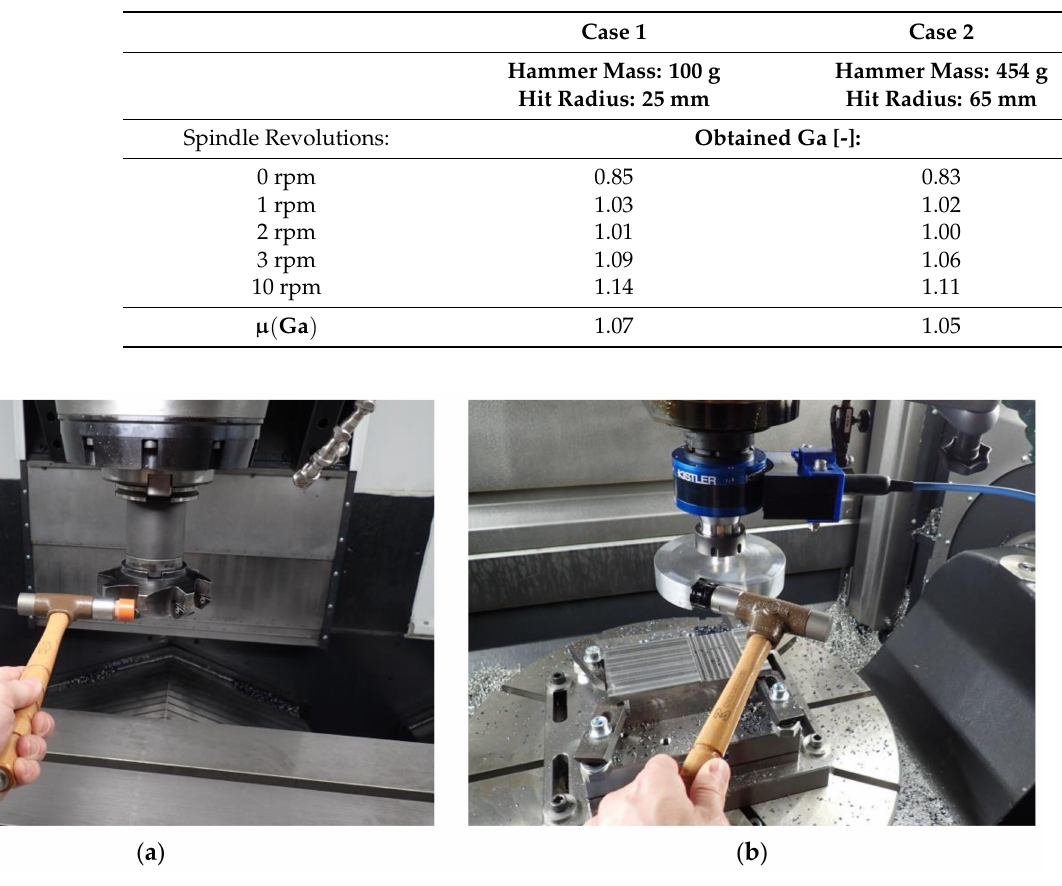
Figure 6. Final calibration setup for both case studies: ( a ) final configuration for Case study A; ( b ) final configuration for Case study B. Table 2. Gain factors and errors corrected by the calibration